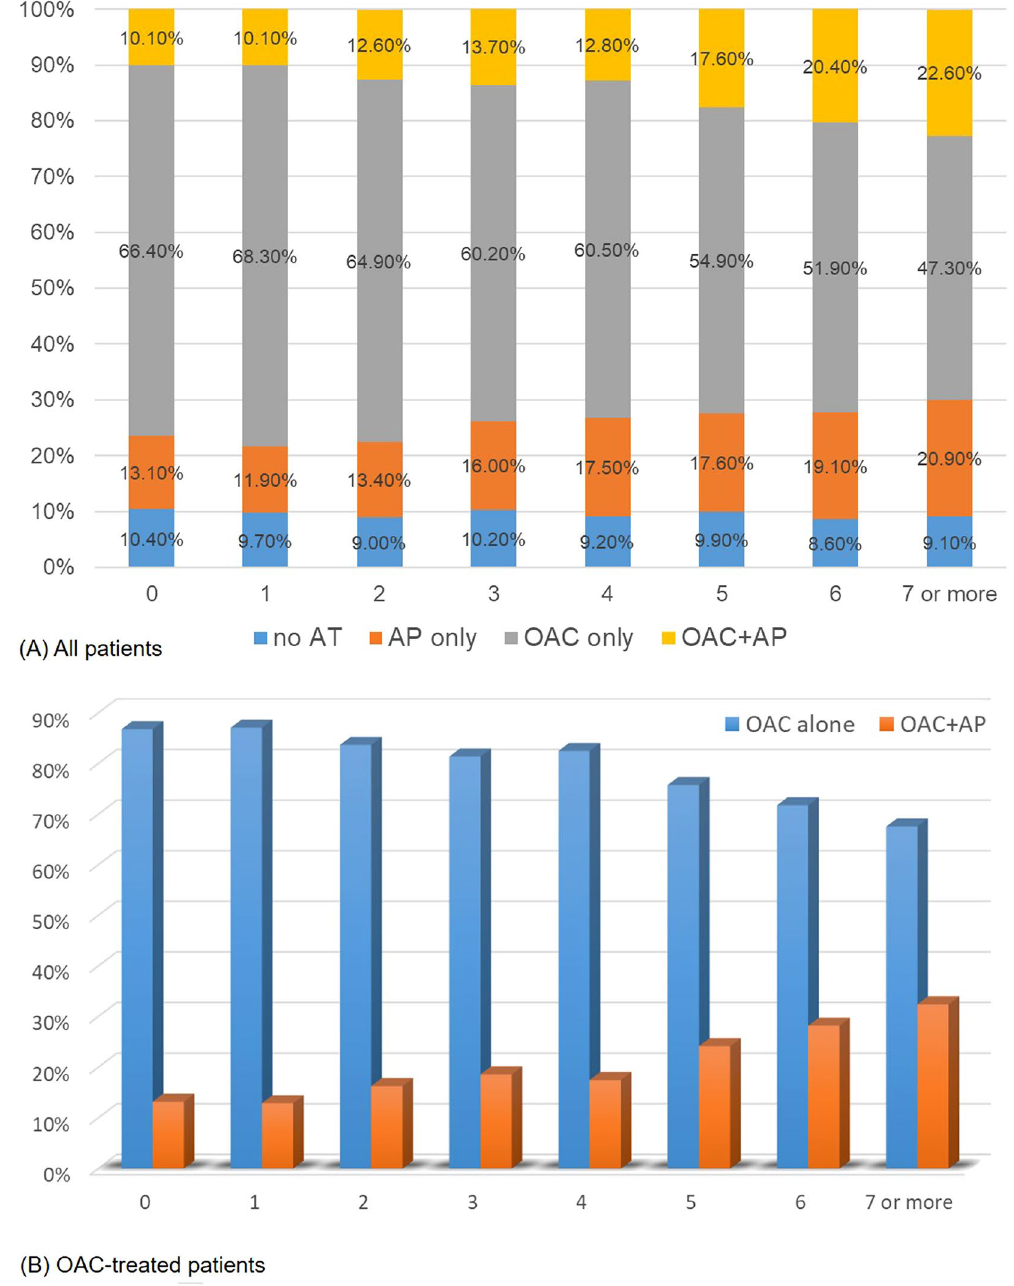
Figure 2. Proportions of antithrombotic treatment according to the CHA2DS2-VASc scores in all patients ( A ) and OAC-treated patients ( B